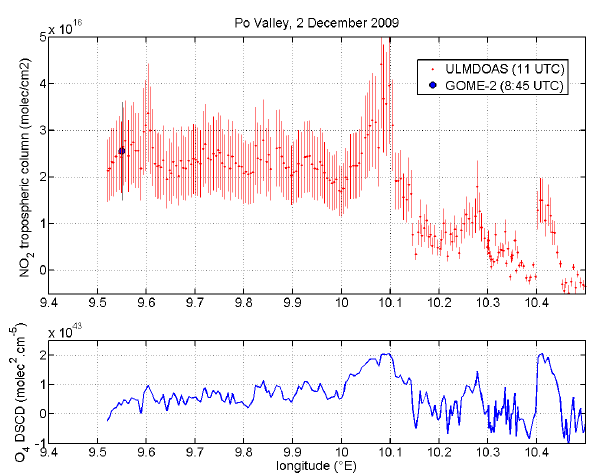
Fig. 10. ULM-DOAS (red) and GOME-2 (blue) measurements over Italy (2 December 2009). ULM-DOAS data were recorded between 10:29 and 12:14UTC and cover the latitude range from 44.58 ◦ to 45.54 ◦ . The zone west of 10 ◦ E is the Po Valley.